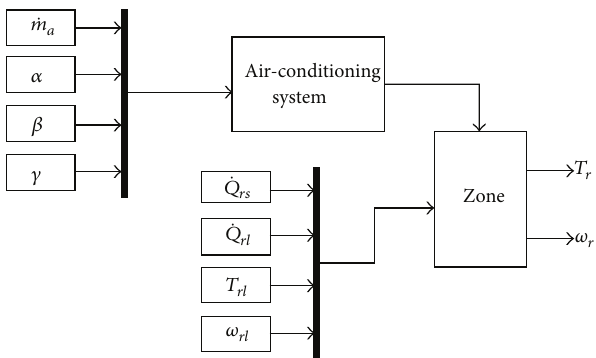
Figure 6: Schematic diagram of thermal model for air-conditioned zone. Figure 7: Block diagram of controlled temperature and humidity of an air conditioning system.